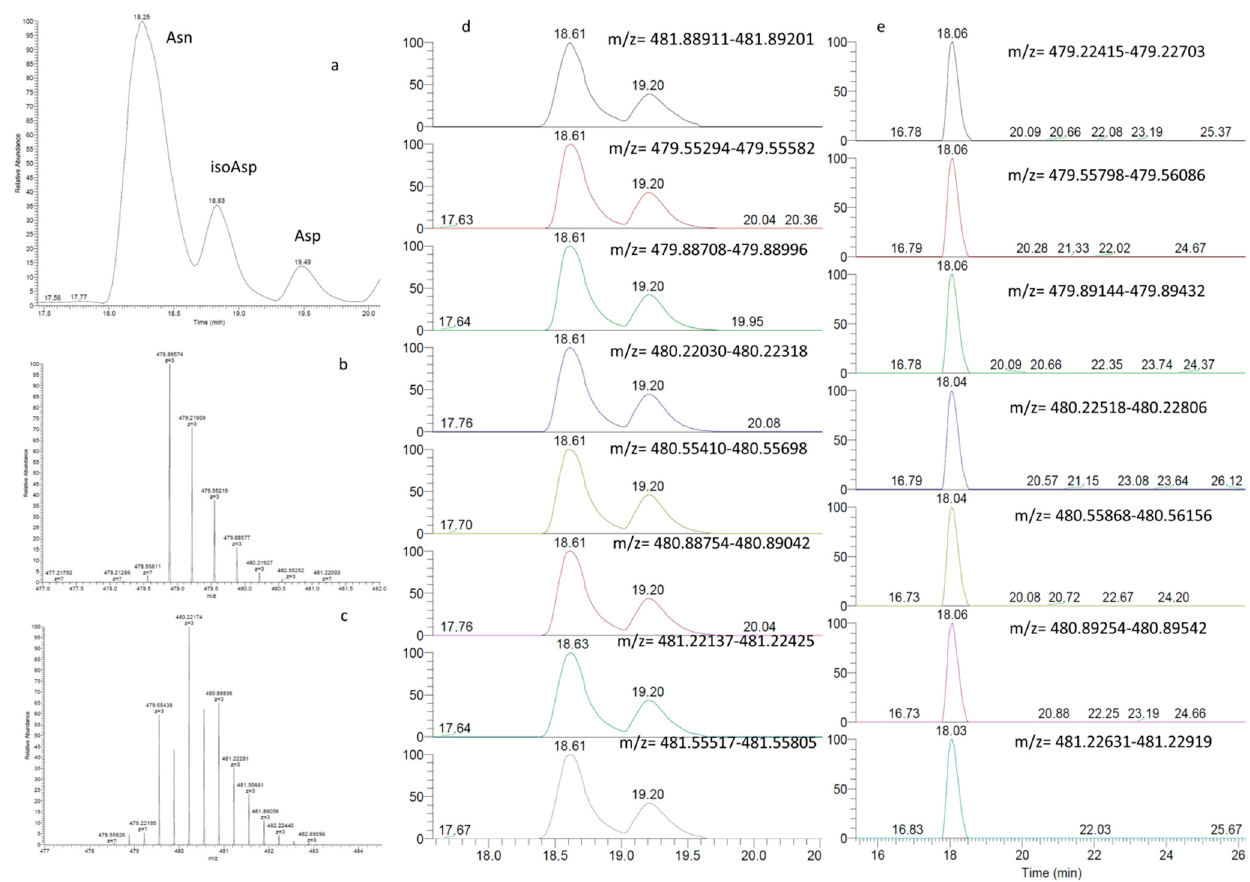
Figure 3. TIC and EICs of Asn, isoAsp, and Asp. ( a ) TIC plots of Asn, isoAsp, and Asp. ( b ) Mass spectrum of the Asn- 18 O peak in the isotopically labelled sample. ( c ) EIC of the isotopic peaks from Asn- 18 O in the 18 O-labelled sample. ( d ) Mass spectrum of Asp- 18 O and isoAsp- 18 O in the isotopically labelled sample. ( e ) EIC of the isotopic peaks from Asp and isoAsp in the 18 O labelled sample.